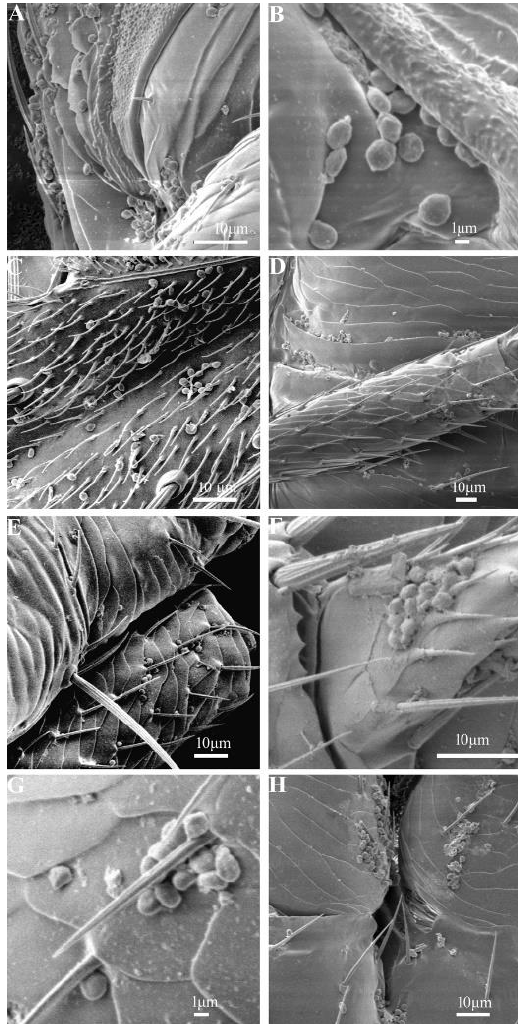
Figure 3. Representative SEM images of the fungal infection process. B. bassiana conidia visualized: ( A ) on the insect cuticular folds, ( B ) at the base of the wings, ( C ) attached to the wings, ( D ) on the surface of the insect legs/feet, ( E ) on the propodium, ( F ) at the apotelus, ( G ) around the setae, and ( H ) adhering between the pereiopoda and metapedes.